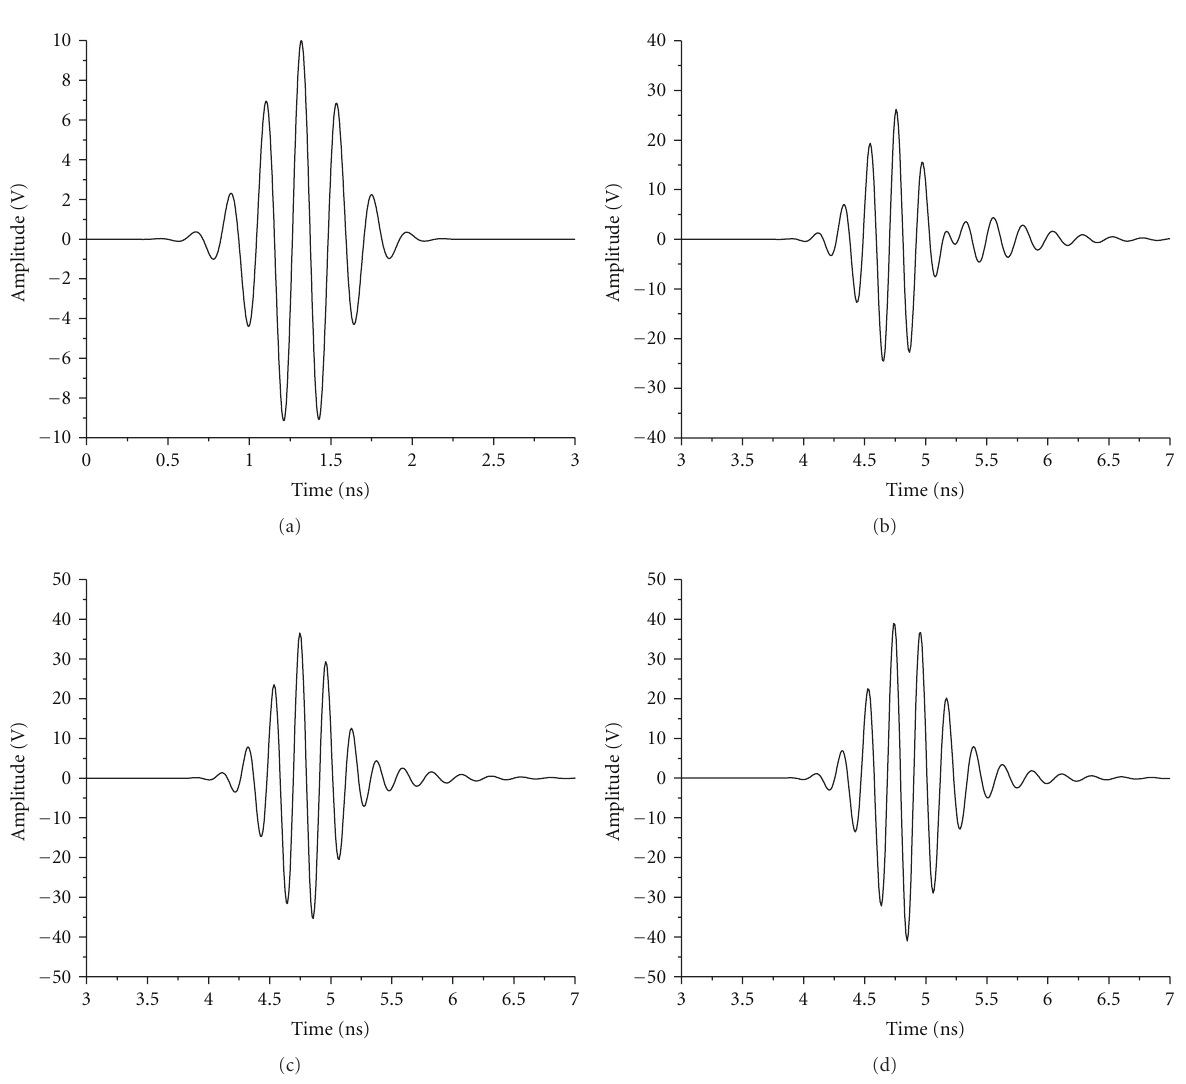
Figure 5: Transmitted signal and received signals of the antenna with di ff erent angles of phi, at theta = 90 degree. (a) Transmitted signal, (b) received signal of the proposed antenna with angle phi = 240 degree, (c) received signal of the proposed antenna with angle phi = 270 degree, and (d) received signal of the proposed antenna with angle phi = 300 degree.